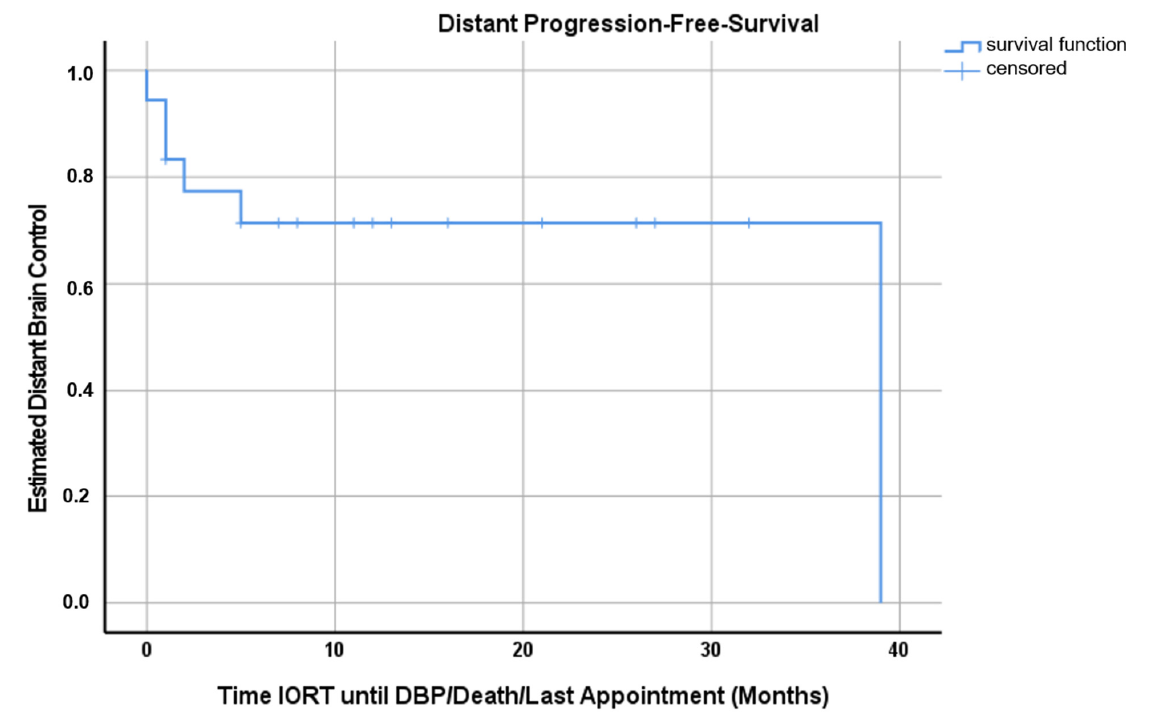
Figure 3. Kaplan–Meyer curve for distant progression-free survival. At one year after IORT, distant brain control was 71.4% (95%-CI 50.2–92.6%).